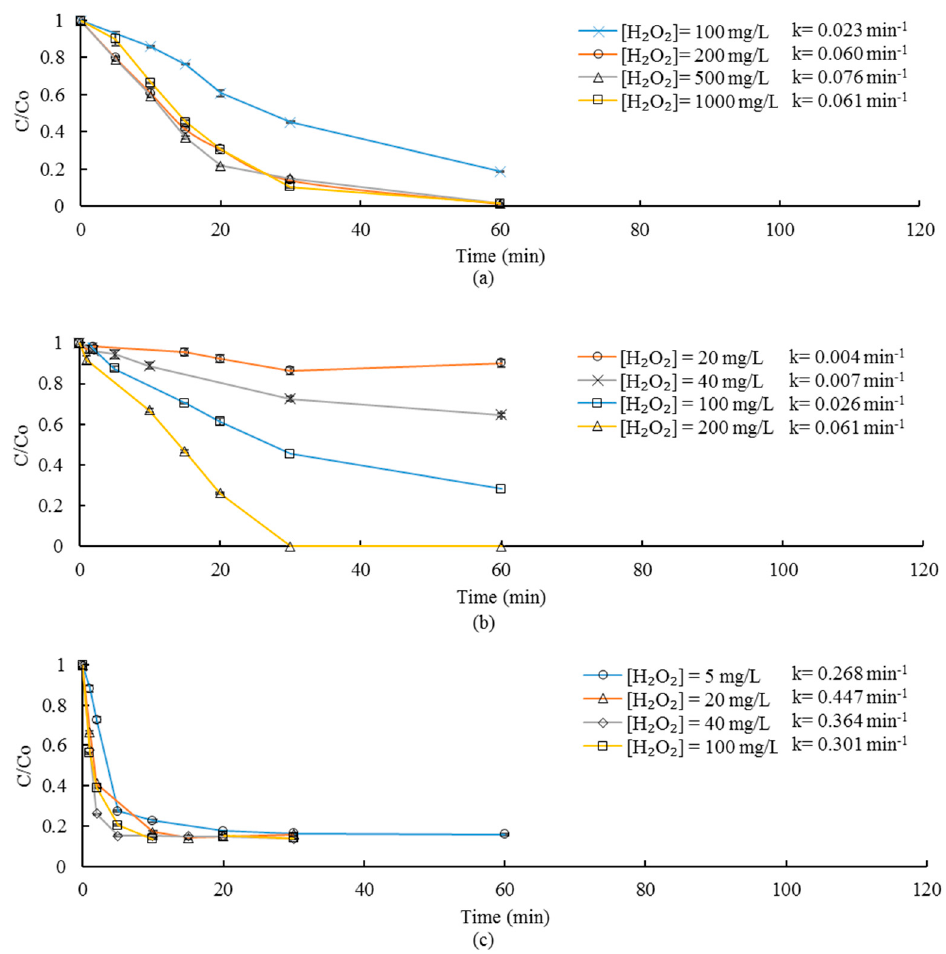
Figure4. Sulfolane degradationin soil washwater (SWW)with UV / H 2 O 2 ; ( a ) nodilution, Co = 100 mg / L; Figure 4. Sulfolane degradation in soil wash water (SWW) with UV/H 2 O 2 ; ( a ) no dilution, Co = 100 ( b ) 5 × dilution, Co = 20 mg / L; ( c ) 500 × dilution, Co = 0.2 mg / L. The error bars represent the variation mg/L; ( b ) 5 × dilution, Co = 20 mg/L; ( c ) 500 × dilution, Co = 0.2 mg/L. The error bars represent the of variation of duplicates.